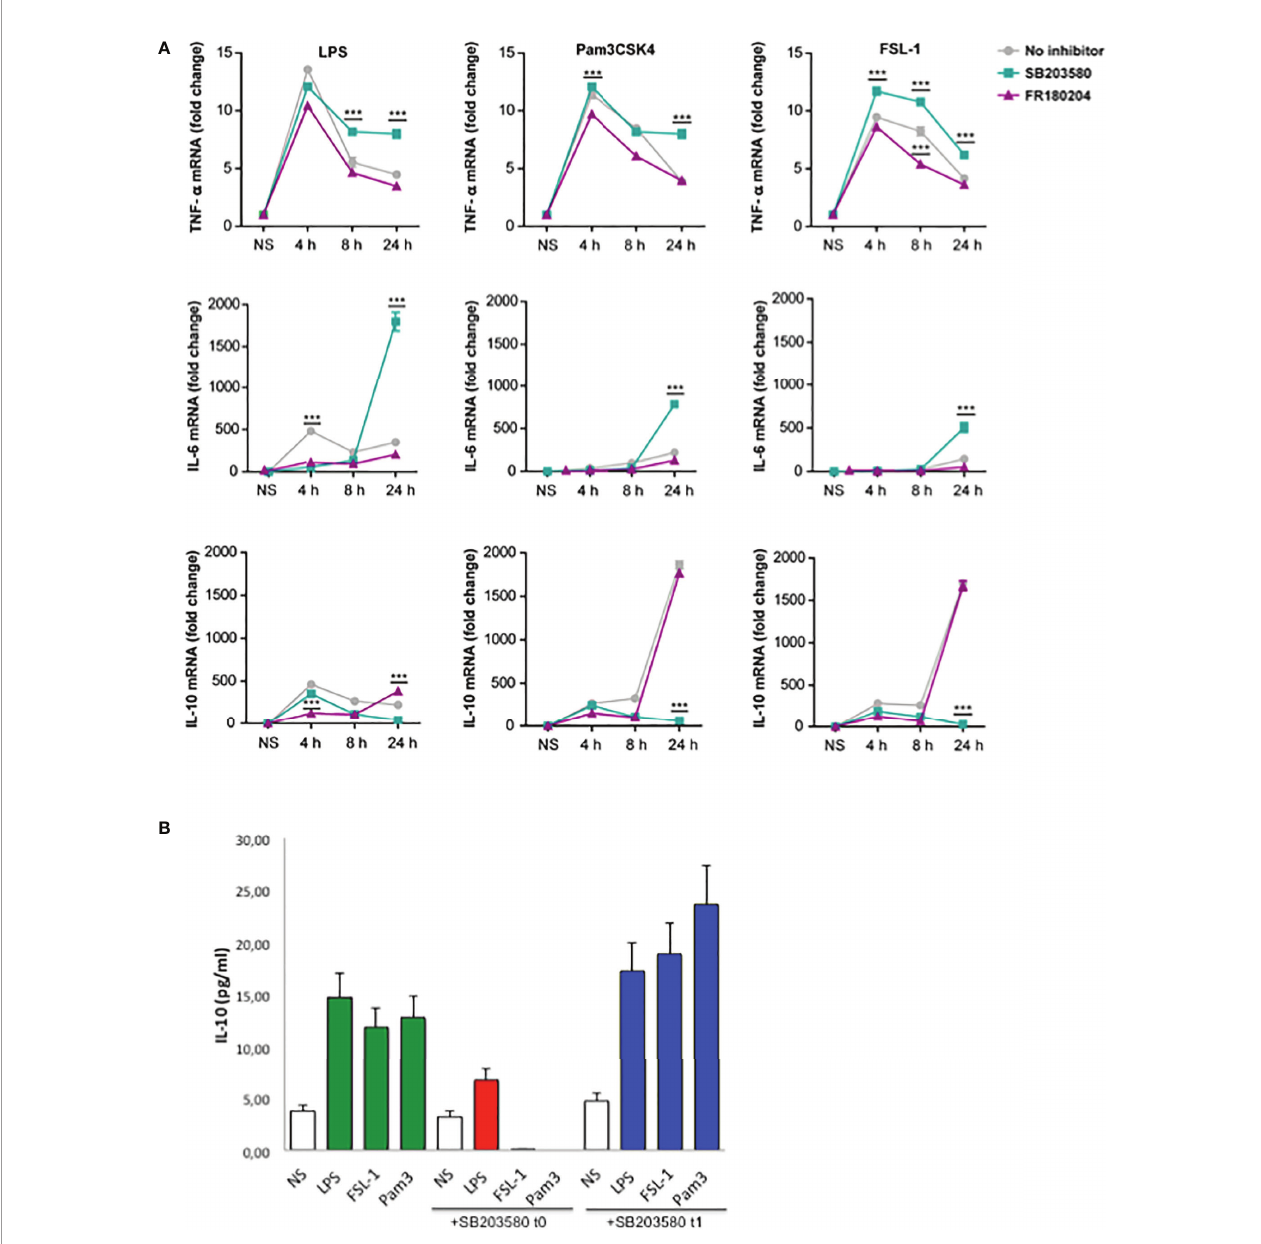
FIGURE 5 | Early p38 activation contributes for later IL-10 production in response to TLR2 ligands. (A) Raw264.7 cells were pre-treated with 10 µM SB203580 or 10 µM of FR180204 for 30 min and then stimulated with LPS (100 ng/mL), Pam3CSK4 (1 µg/mL) and FSL-1 (100 ng/mL) for 24 hours. Cytokines mRNA expression was assayed by quantitative RT-PCR, normalized to RPL13A, and presented relative to unstimulated cells (NS). Data from triplicate cultures are representative of three independent experiments (mean ± SEM.) (***p < 0.001). (B) Raw264.7 cells were treated with 10 µM SB203580 at the same time (t0) or 60 min (t1), after stimulation with LPS (100 ng/mL), Pam3CSK4 (1 µg/mL) and FSL-1 (100 ng/mL). Cell supernatants were collected after 24 hour-stimulation and IL-10 cytokine protein levels were measured by ELISA. Data are the mean of 2